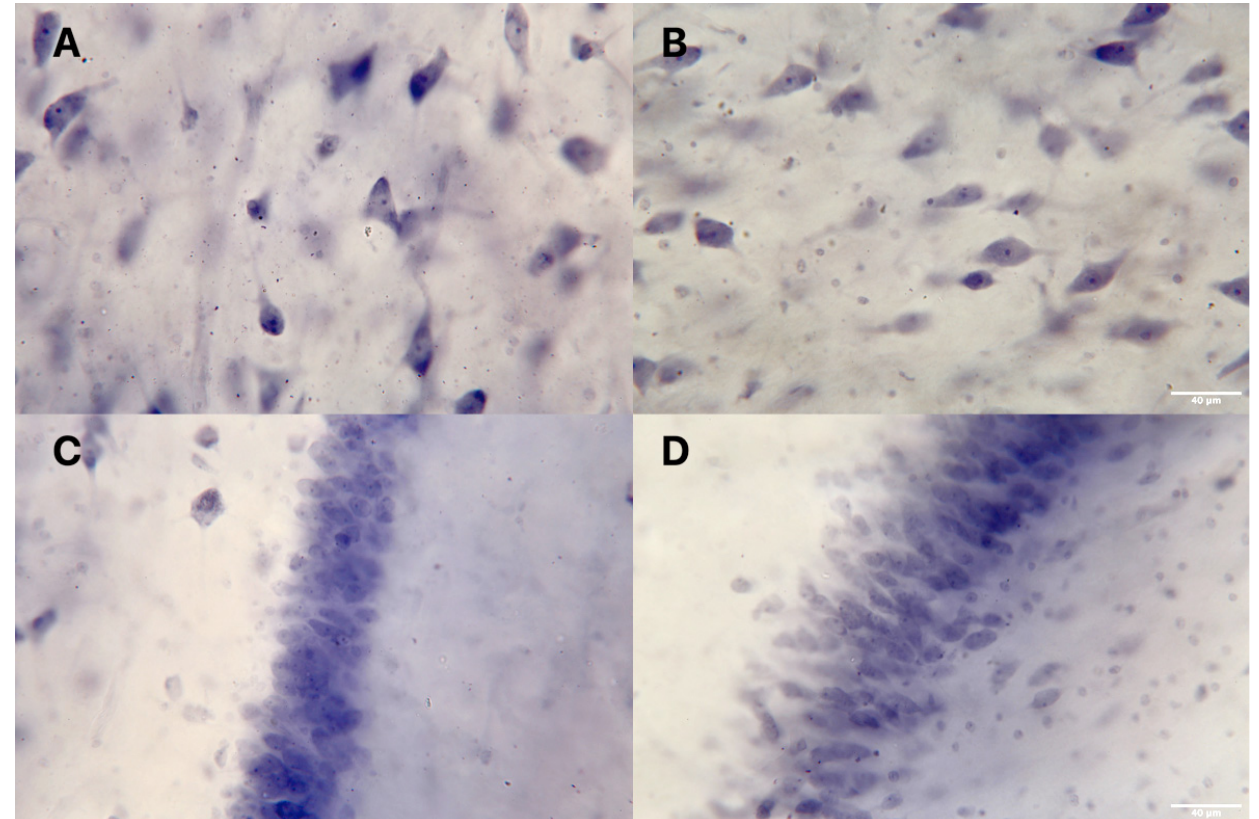
Figure 3. Representative photomicrographs of the cornu ammonis 4 (40× magnification) from a patient with schizophrenia ( A ) and a healthy control ( B ) and of the dentate gyrus from a patient with schizophrenia ( C ) and a healthy control ( D ).